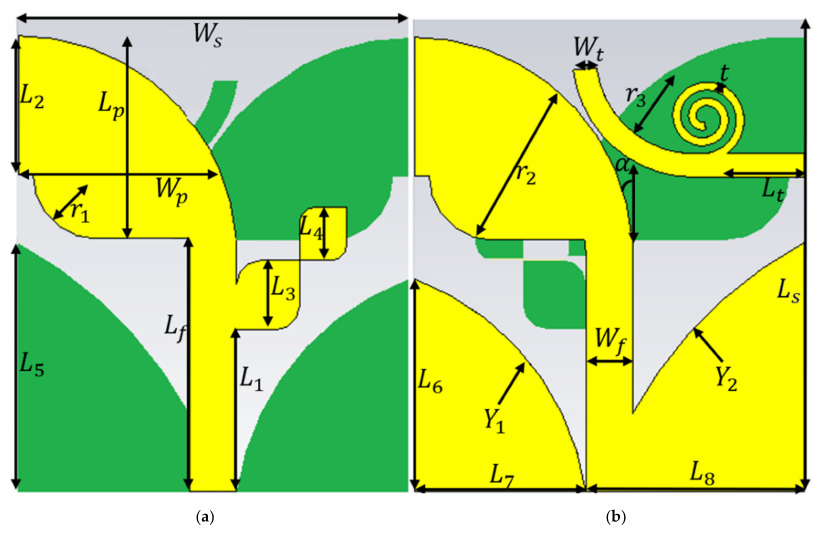
Figure 1. The simulated prototype of the proposed antenna: ( a ) front and ( b ) back view (both green and yellow colors are the conductors. Their color is different only to differentiate the front and back view of